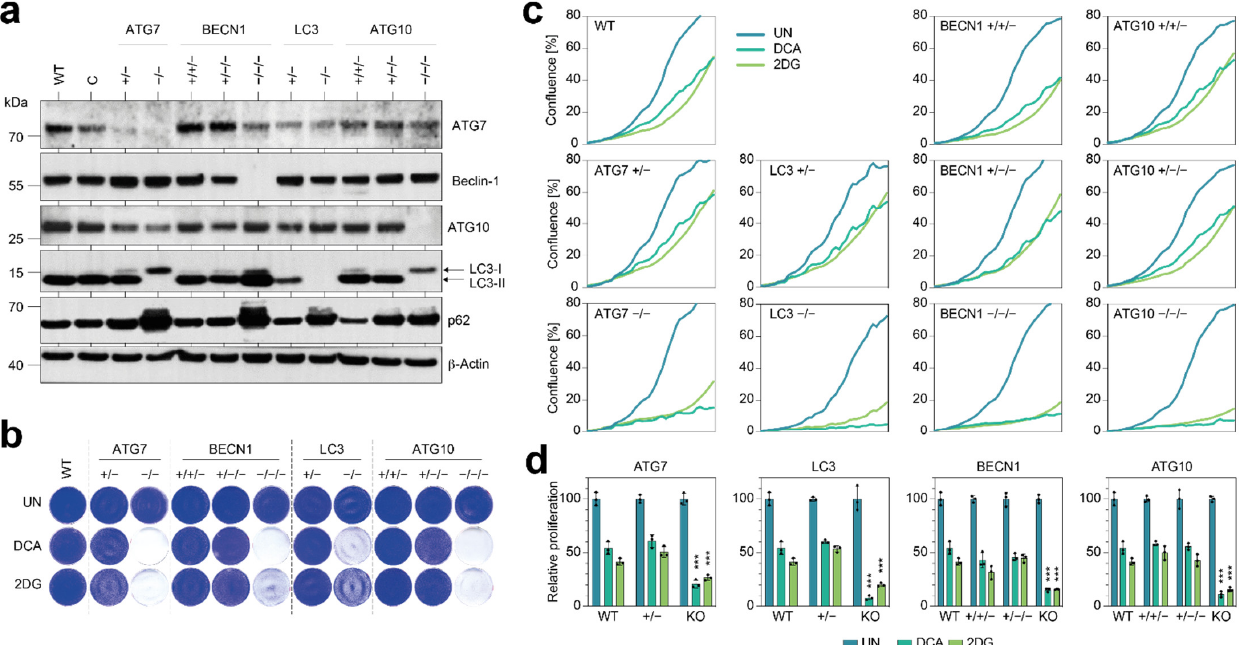
Figure 3. Tumor cells with nonhomozygous copy number losses in single ATGs maintain proliferation under metabolic stress. ( a ) Western blot for ATGs. β -Actin is shown as loading control. C, control clone transfected with nontargeting nuclease and WT, wild-type H460. ( b ) Clonogenic growth assay. ( c , d ) Real-time live cell imaging of cells under treatment. ( c ) Proliferation kinetics. Shown is the mean confluence in % ( n = 3). ( d ) AUC of proliferation curves shown in ( c ) relative to untreated. Shown is the mean ± SD ( n = 3). Differential treatment responses were tested for statistical significance by 2-way ANOVA and Dunnett’s multiple comparisons test. p -values denote pairwise comparisons of mutant with parental wild-type cells; ***, p < 0.0001. UN,